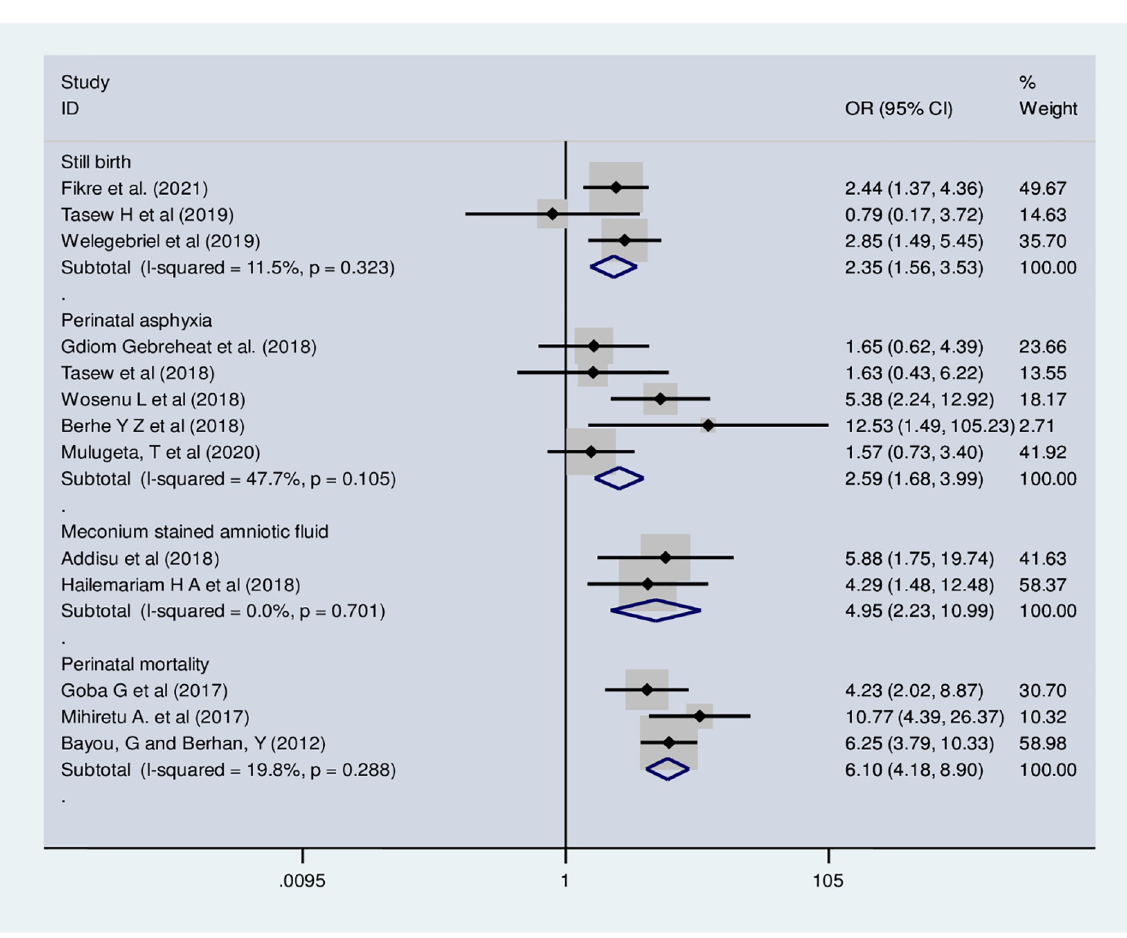
Fig 8. Forest plot of association of obstructed labor with uterine